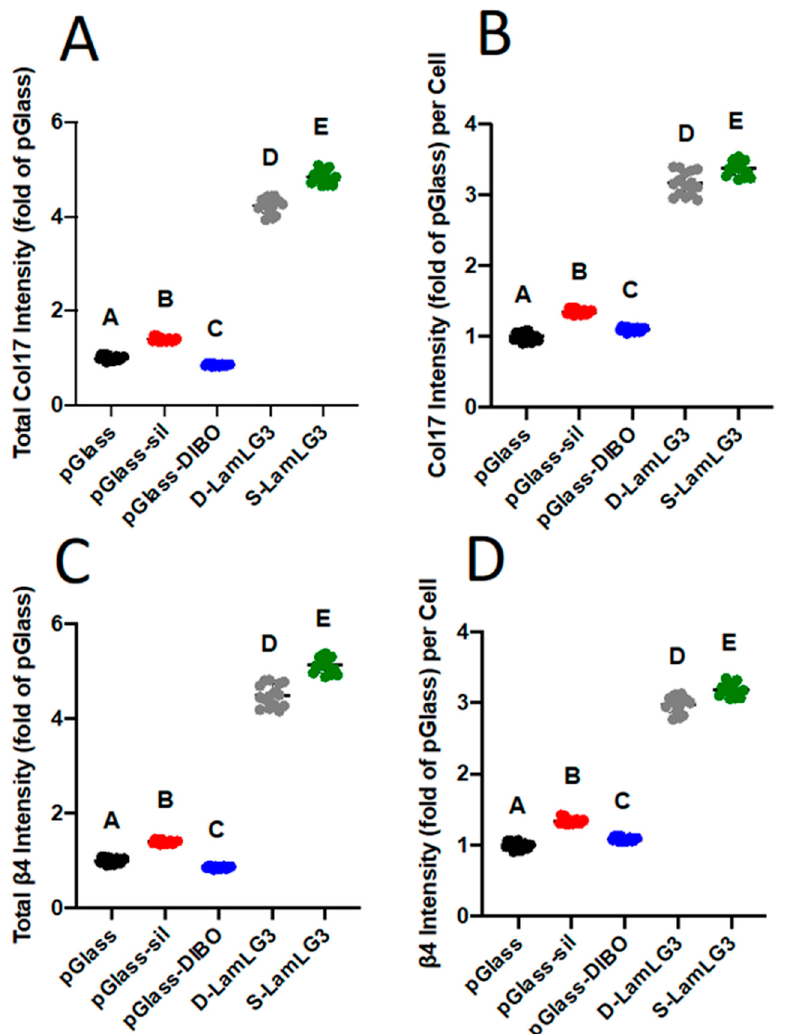
Figure 5. Oral keratinocyte hemidesmosome formation [total collagen XVII intensity ( A ), collagen XVII intensity normalized to number of cells ( B ), total integrin β 4 intensity ( C ), and integrin β 4 intensity normalized to number of cells ( D )] of coated and non-coated, control surfaces at 1 day. Differences in mean between groups were assessed with a one-way analysis of variance (ANOVA) table followed by a Tukey’s HSD (honest significant difference) post hoc test. A p value of <0.05 was considered statistically significant. Dissimilar letters denote statistically significant differences between groups.